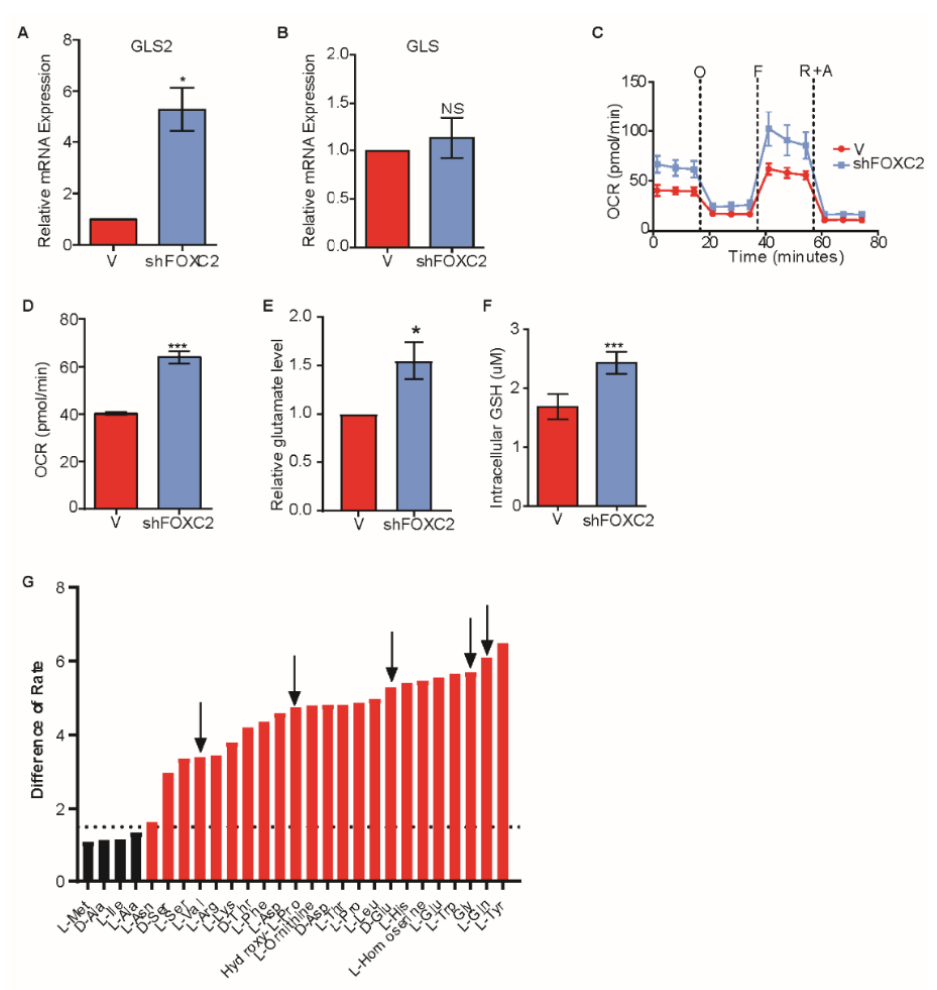
Figure 4. Inhibition of FOXC2 enhances GLS2 expression and glutamine utilization. ( A , B ) RT-PCR analysis of A) GLS2 mRNA and B) GLS mRNA in HMLER cells that express Snail without (−) or with (+shFOXC2) expression of shFOXC2. ( C ) OCR of HMLER cells that express Snail without (−, n = 6) or with (+shFOXC2, n = 6) shFOXC2 over time (in minutes) after addition of oligomycin (O), FCCP (F), and rotenone and antimycin (R + A). ( D ) Basal respiration rate (pmol/min) of HMLER cells that express Snail without (−, n = 6) or with (+shFOXC2, n = 6) shFOXC2. ( E ) Quantification of intracellular glutamate per 1 × 10 3 HMLER cells that express Snail without (−, n = 3) or with (+shFOXC2, n = 3) shFOXC2. ( F ) Quantification of intracellular GSH in HMLER cells that express Snail without (−, n = 4) or with (+ shFOXC2, n = 5) shFOXC2. ( G ) Difference in utilization between HMLER cells that express Snail without (−, n = 3) or with (+shFOXC2, n = 3) shFOXC2 at 8 hours. Negative values indicate metabolic loss. Positive values indicate metabolic gain. Dotted lines at −1.5 and 1.5 are designated cutoffs to indicate significance in loss (green bars) and gain (red bars). Black arrows point out the amino acids restored from Figure 2A. Plotted are means ± SD; * p ≤ 0.05, ** p ≤ 0.01, *** p ≤ 0.001, NS indicates p > 0.05.